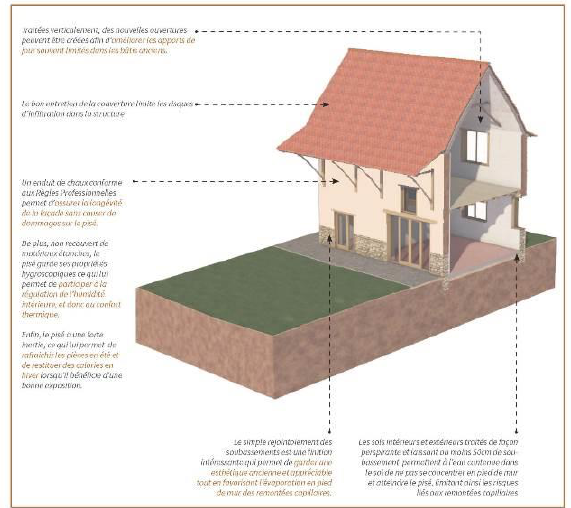
Figure 3. Drawing extracted from the guide presenting some characteristics of rammed earth vernacular heritage © Osmia architecture